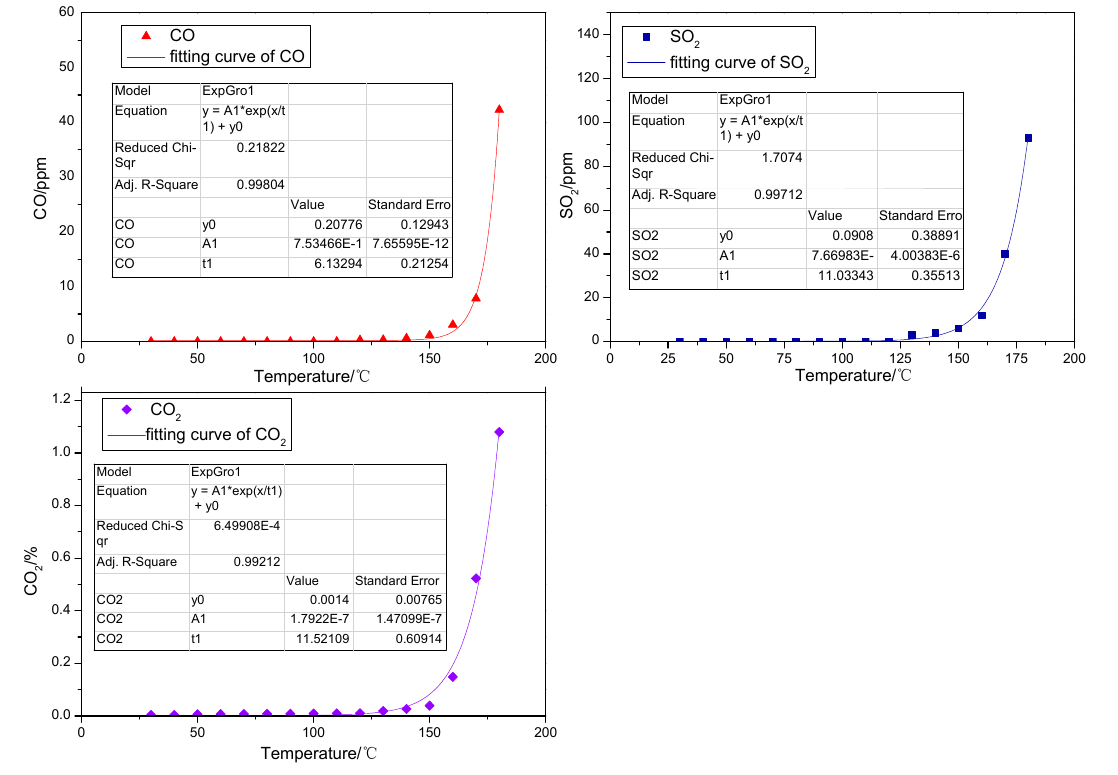
Figure 2. The oxidation product curve of the model compound cysteine.